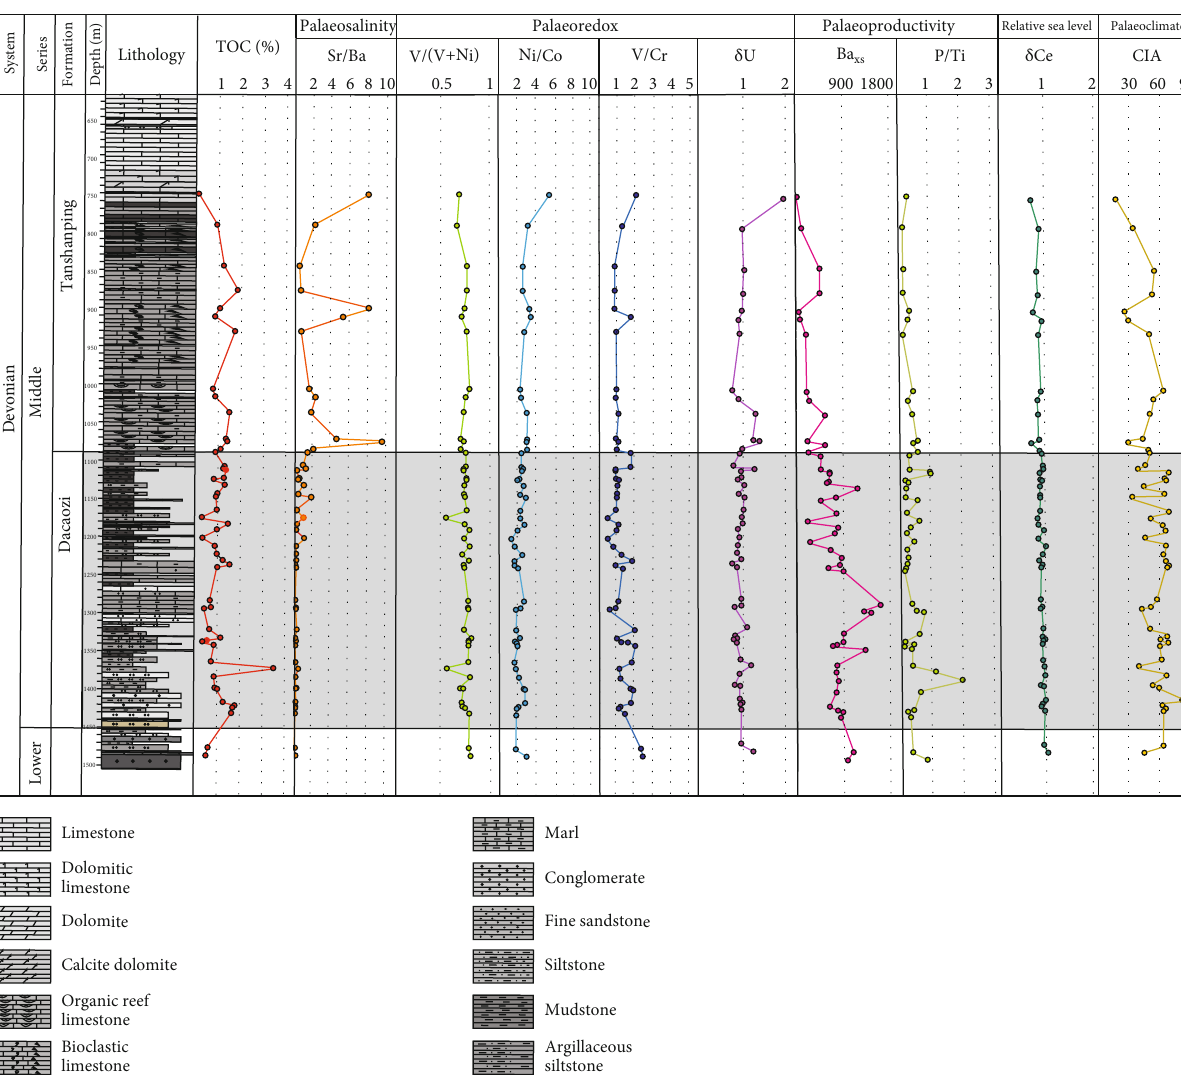
Figure 6: Paleoproductivity, paleoredox, paleosalinity, paleoclimate, relative sea level, and TOC content of Well Yunningdi-1 in the Tanshanping Formation and Dacaozi Formation in the Ninglang-Yanyuan area (see Figure 2 for the well